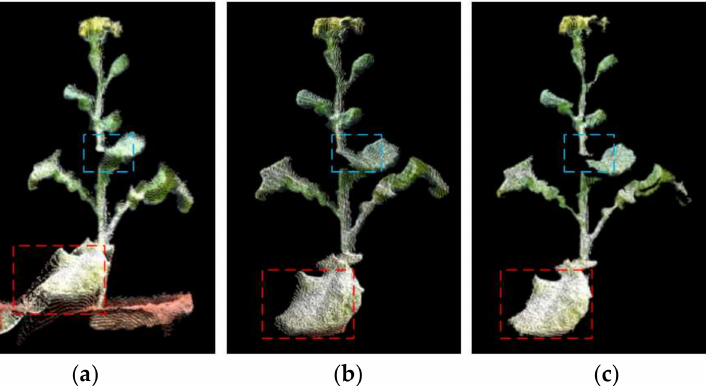
Figure 8. Comparison of two filtering effects. ( a ) The original point cloud. ( b ) Pass-through filtering and statistical filtering. ( c ) Neighborhood extreme filtering and pass-through